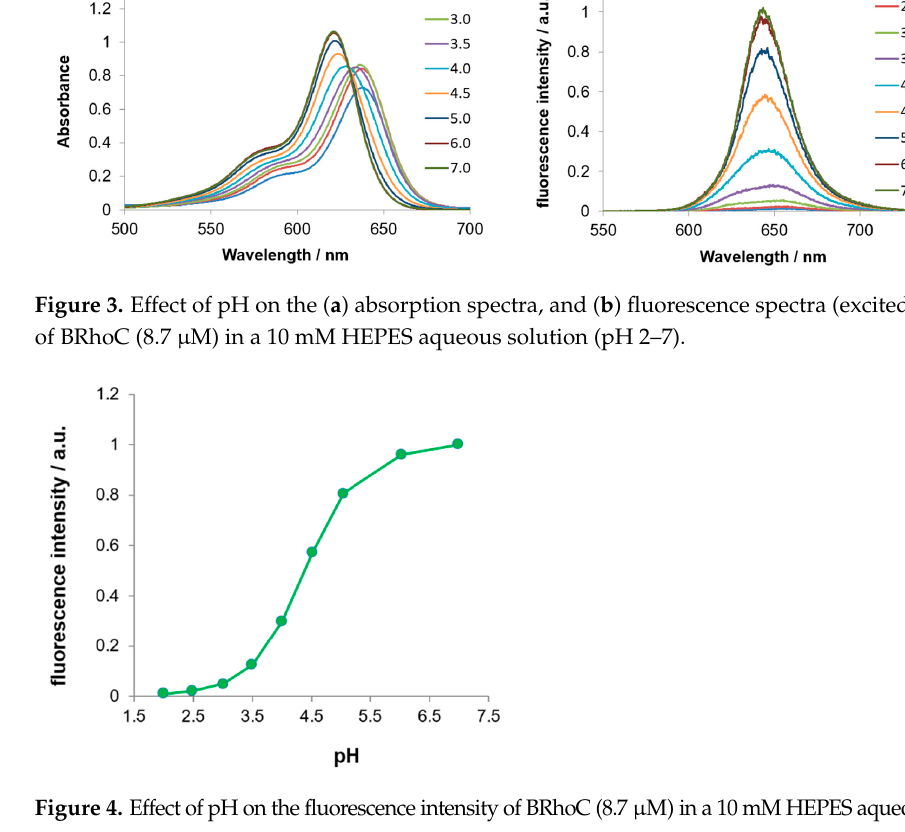
Figure 5. Effect of different concentrations of Fru (0, 1, 2, 5, 10, 20, 50, and 100 mM) on the ( a ) ab- sorption spectra, and ( b ) fluorescence spectra (excited at 621 nm) of BRhoC (8.5 μ M) in a 10 mM HEPES buffer at pH 7.4. Figure 6. Effect of different concentrations of Glc (0, 10, 20, 50, 100, 200, 500, and 1000 mM) on the ( a ) absorption spectra, and ( b ) fluorescence spectra (excited at 621 nm) of BRhoC (8.5 μ M) in a 10 mM HEPES buffer at pH 7.4.